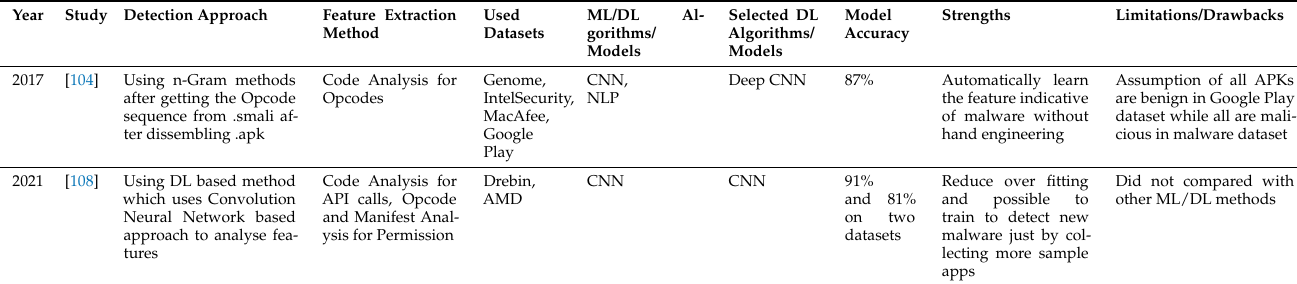
Table 8. Deep learning based Malware Detection Approaches (Model Accuracy is below 90% or overall accuracy is not available).